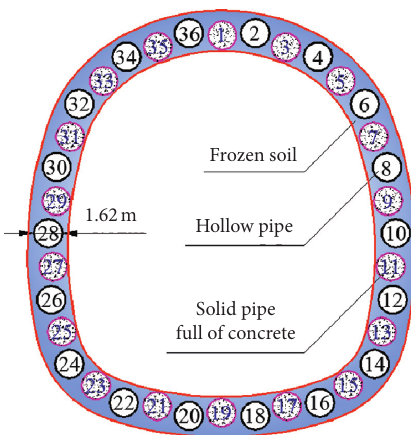
Figure 5: Schematic diagram of the pipe roof freezing ring.